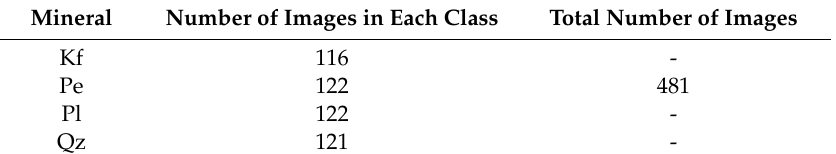
Table 2. The numbers of sample data of rock-mineral microscopic images.